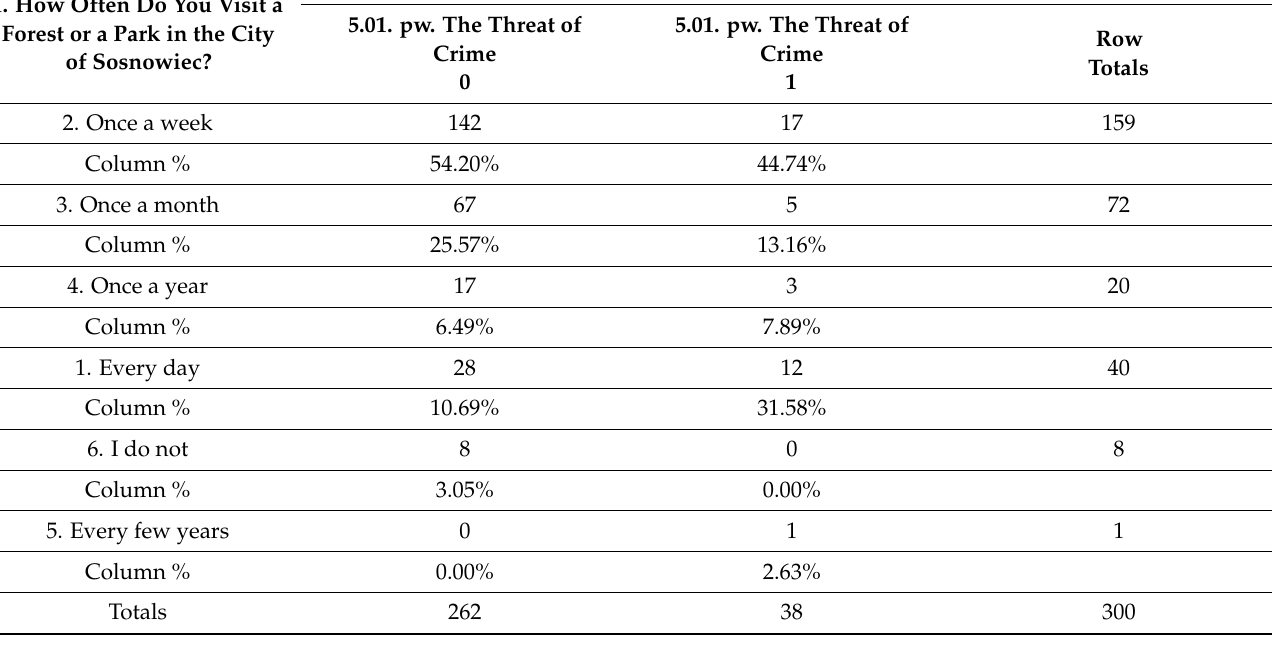
Two-Way Summary Table: Observed Frequencies (BASE) Marked Cells Have Counts >